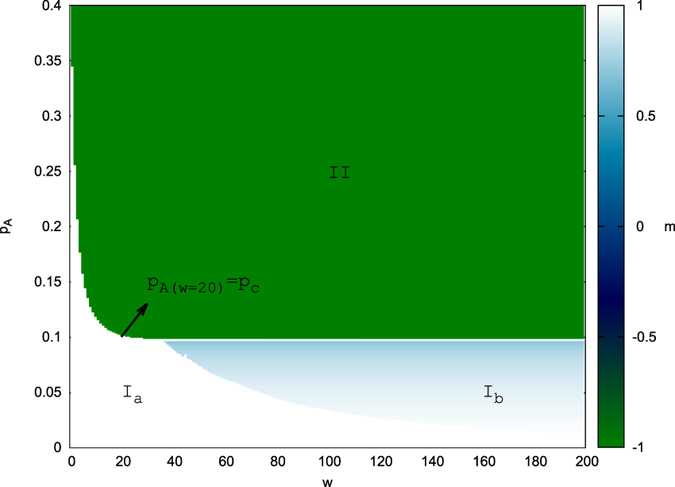
Mean-field diagram of the waning commitment naming game with single committed group.The quantity m is calculated when the steady state condition of a system is satisfied. The system starts with the initial values of a0 = c = 0, b0 = 1 − pA. Three regions of fixed points, Ia, Ib and II are shown and discusses in the text.